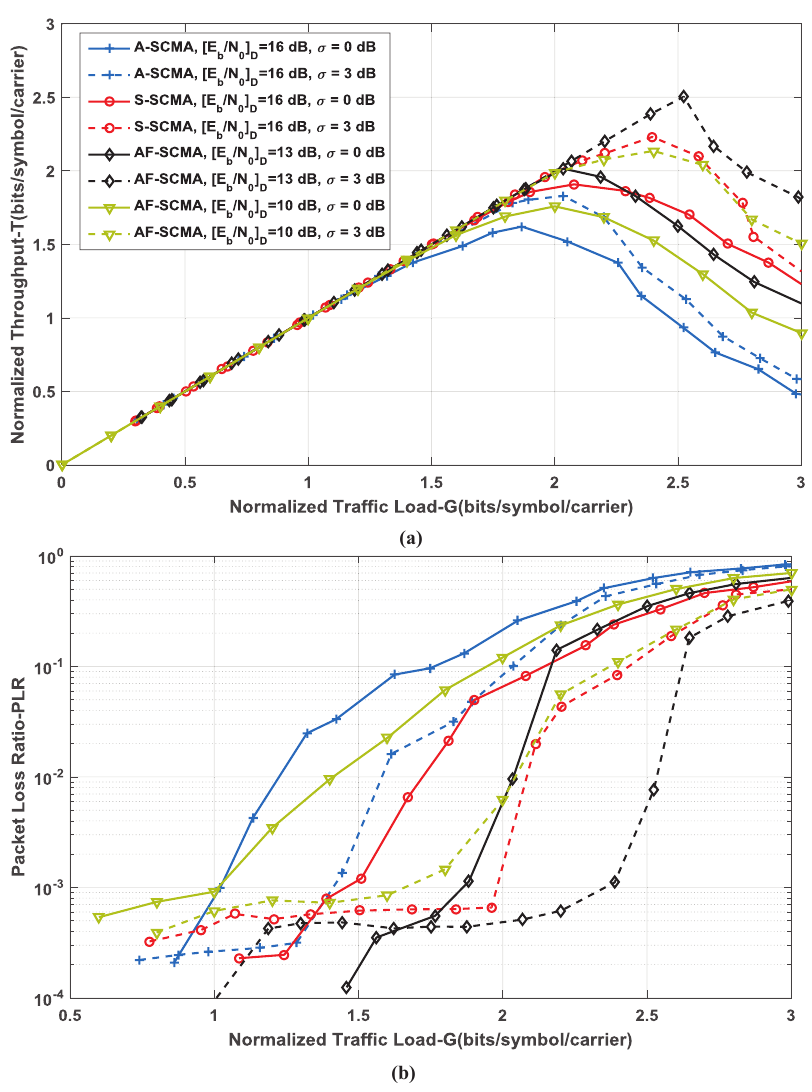
Figure 4. Performance comparison among A-SCMA, S-SCMA and AF-SCMA for packet size 500 bits, Turbo encoder with r = 1/3, SCMA (4, 6), N chunk = 10 (AF-SCMA), N iter = 10, in the presence of power unbalance with µ = 0 and σ = 0,3 dB respectively (Legends in the two sub-figures are the same. To avoid overlapping the curves, legends are only marked in sub-figure ( a )). ( a ) Throughput. ( b )